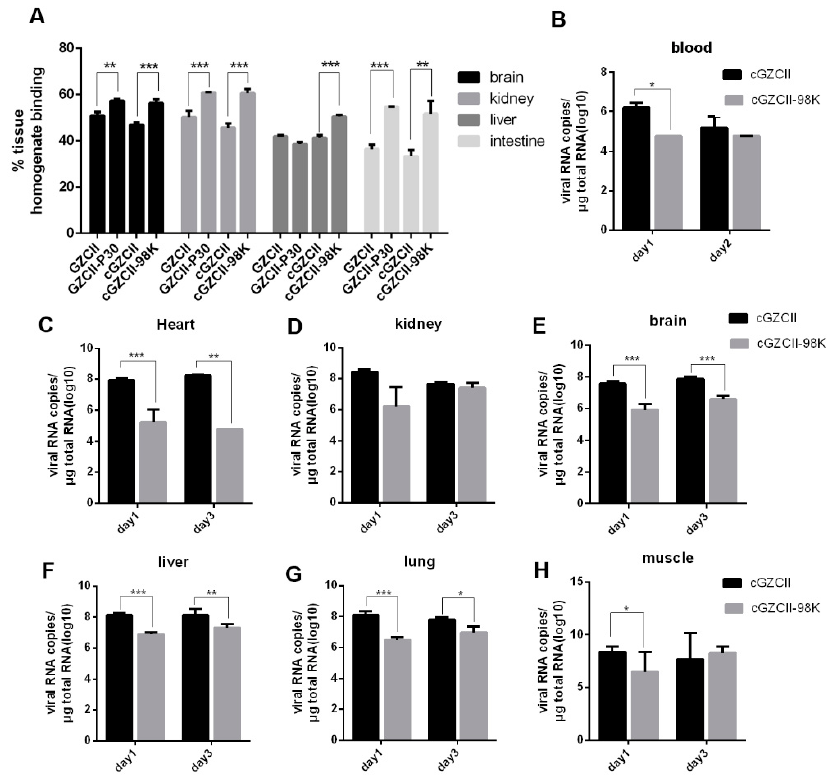
Figure 9. Binding efficiency and replication of GZCII variants in vivo . ( A ) Homogenates of mouse brain, kidneys, liver, or intestines ( n = 3) were incubated with ~106 copies of GZCII variants for attachment, and the binding efficiency was determined by qPCR. ( B ) To monitor the viral load in mice, blood was collected at 1 dpi or 2 dpi, and mouse heart ( C ), kidney ( D ), brain ( E ), liver ( F ), lung ( G ), and muscle ( H ) tissues were harvested at 1 dpi or 3 dpi ( n = 3). Viral RNA copy number in 1 μ g of total RNA was determined by qPCR (*: p < 0.05; **: p < 0.01; ***: p < 0.001).